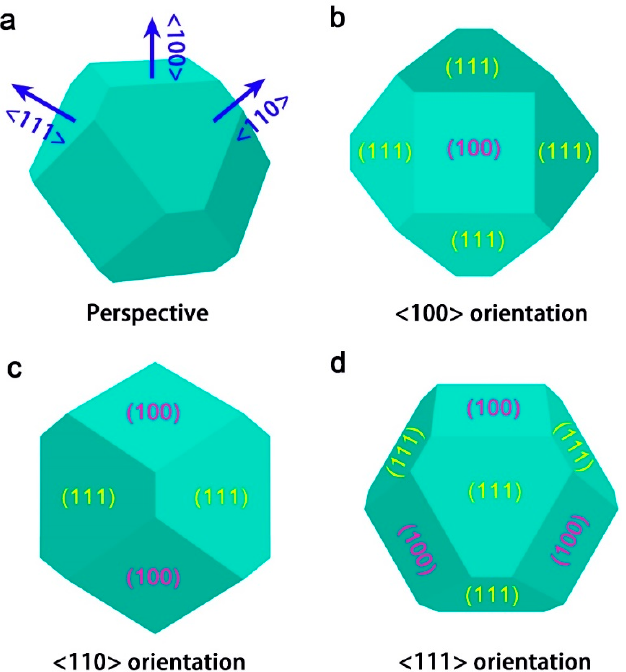
Figure 1. ( a ) Perspective drawing of the tetrakaidecahedral diamond grain. Crystalline faces